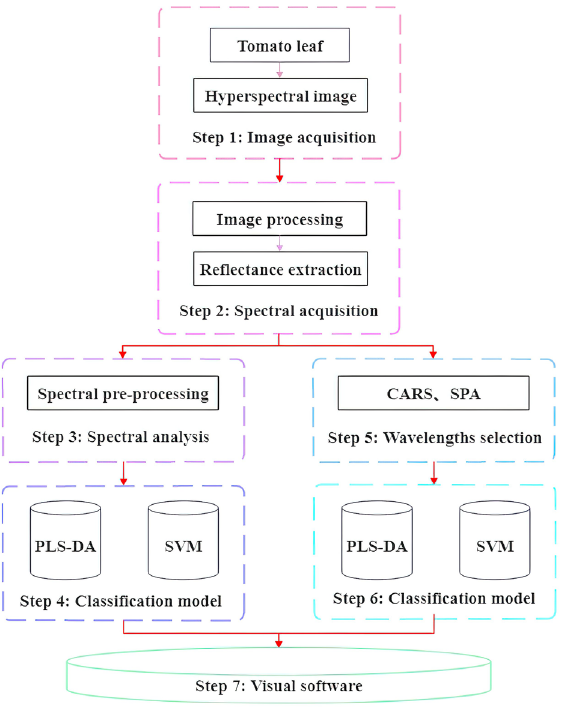
Figure 10. Flow chart of the main steps of hyperspectral imaging-based tomato leaf Sclerotinia sclerotiorum